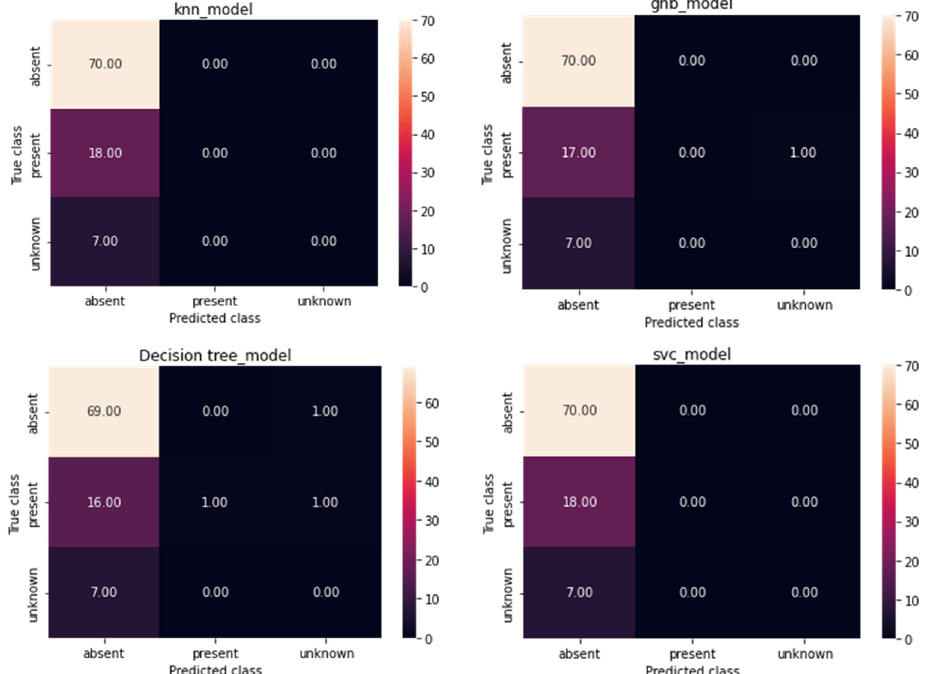
Figure 7. The confusion matrix for the proposed technique for classification of cardiovascular disease.